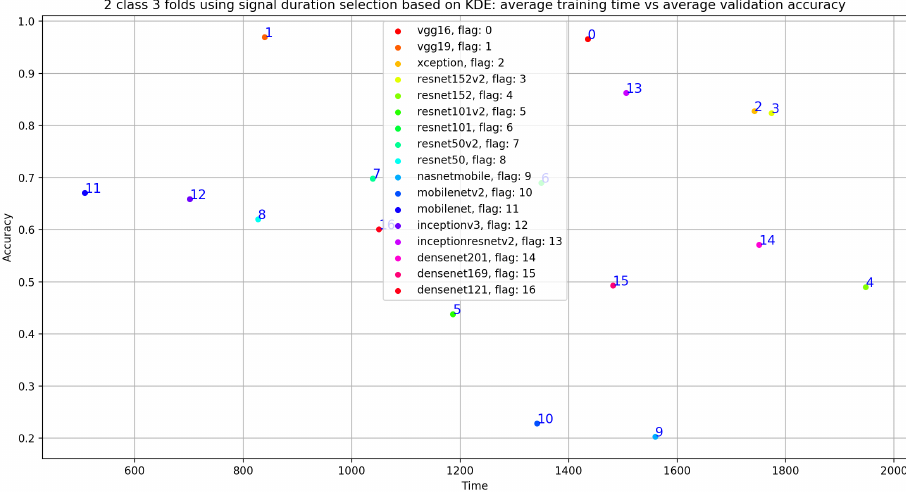
Figure 22. Training time vs. validation accuracy using signal-duration selection based on